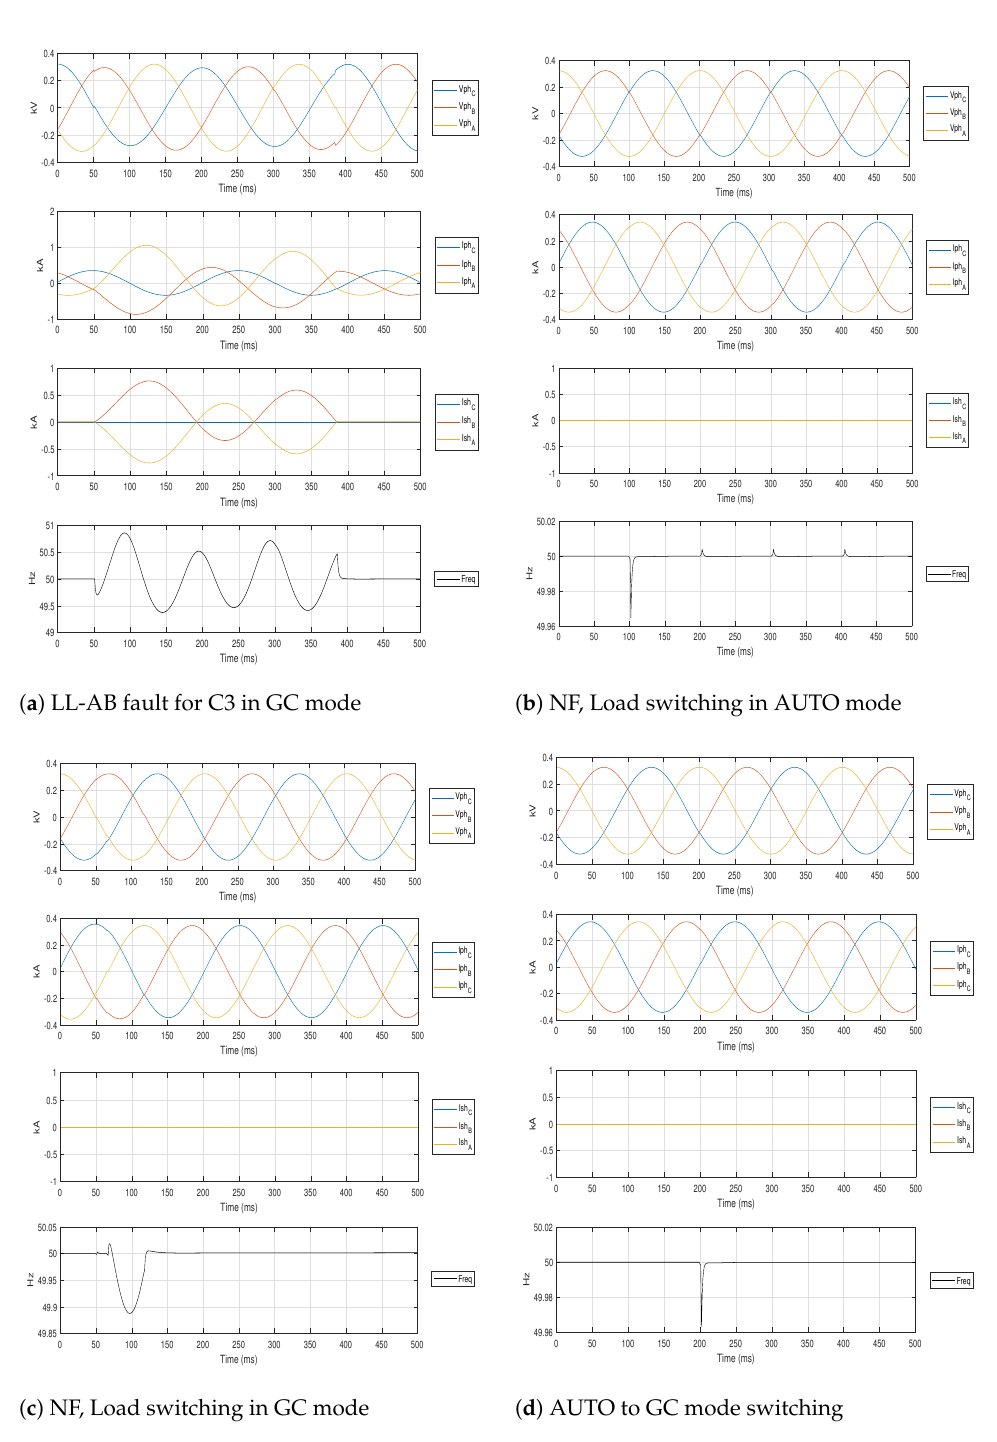
Figure 5. Ten signals for LL-AB Fault and NF conditions. For FD, equal sets for different faults are categorised as Fault, while various cases of normal operation, load switching and grig switching are classified as No Fault (NF). On the other hand, FTC data has been organised to classify the fault type and FP. Data for the NF conditions include simulations of connecting and disconnecting 5 kW, 50 kW and 200 kW load in both modes, switching from GC to AUTO and vice versa with and without load switching. Additionally, simulations without any fault, load or grid switching are also included to differentiate between a fault and NF conditions. Data collected for